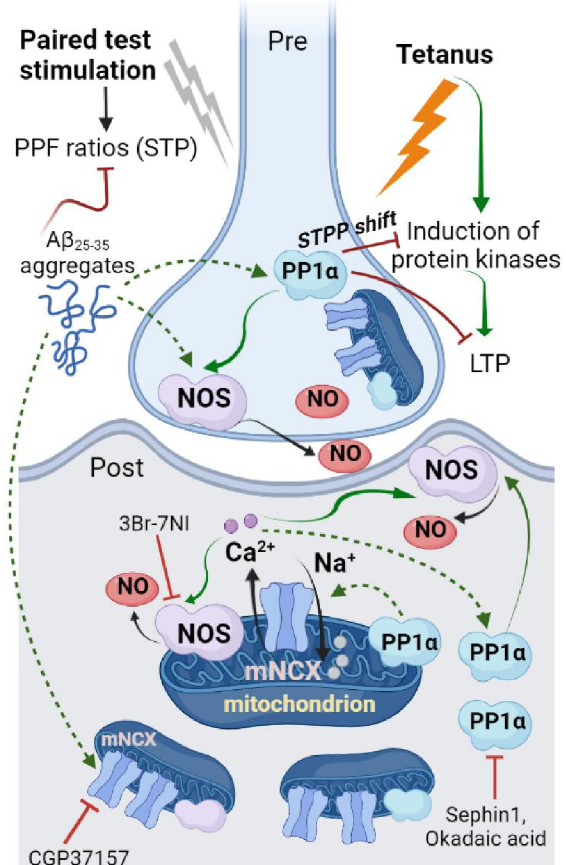
Figure 9. Suggested scheme for Aβ 25-35 -driven neurochemical events in the hippocampal synapses. Aβ 25-35 aggregates (in)directly induced GADD34 and PP1α phosphatase complex activation. PP1α can dephosphorylate the nNOS, leading to disinhibition of nNOS activity followed by NO production. NO acts both pre- and postsynaptically, reducing the number of mediator vesicles and nitro- sylation of protein targets, such as ion channels, enzymes, etc. Furthermore, Aβ 25-35 aggregates